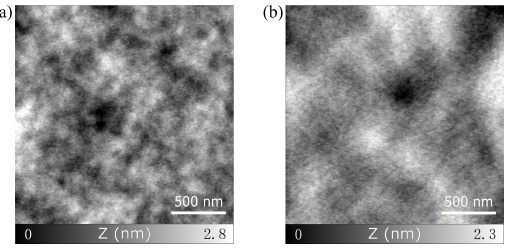
Figure 3. AFM topography images in contact mode of the FL-C:H films with two hydrogen concentrations: ( a ) 0% H, µ = 0.080, S = 0.45 nm ( F N = 10 nN ) . ( b ) 20% H, µ = 0.170, S = 0.36 nm ( F N = 10 nN )